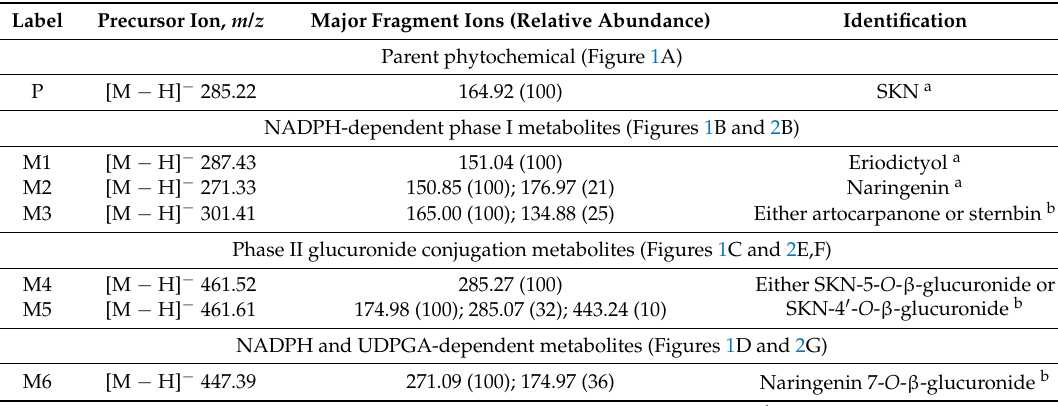
Figure 2. HPLC-electrospray (ESI)-negative mass spectrum of metabolites of SKN dependent on NADPH, UDPGA, or both cofactors. Mass spectrum of SKN ( A ), mass spectrum of M1 ( B ), mass spectrum of M2 ( C ), mass spectrum of M3 ( D ), mass spectrum of M4 ( E ), mass spectrum of M5 ( F ), and mass spectrum of M6 ( G ) are shown. The metabolites are identified in Table 3. Table 3. Phase I and phase II metabolites of sakuranetin (SKN) in human liver